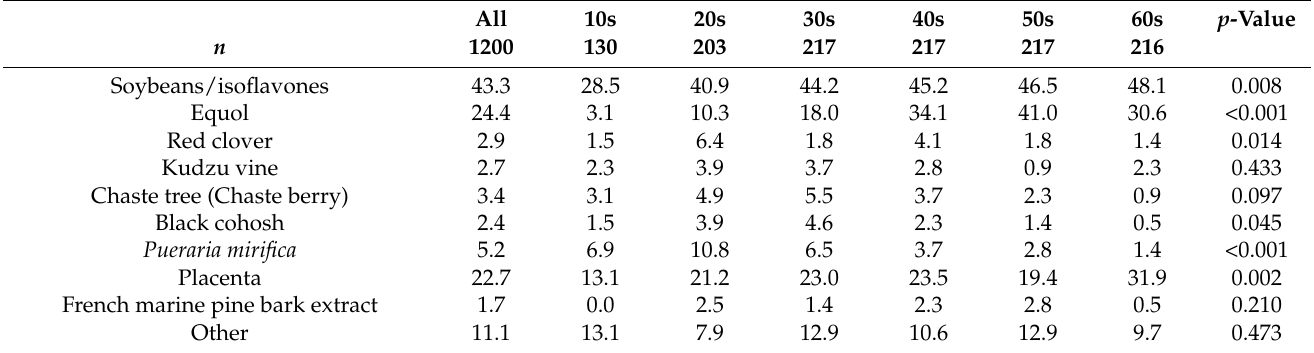
Table 8. The major ingredients of estrogen-like